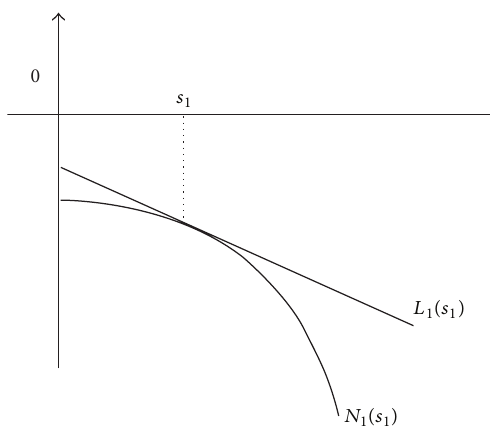
Figure 3: 𝑁 1 (𝑠 1 ) and 𝐿 1 (𝑠 1 ) for 0 ≤ 𝑠 1 ≪ 1 , ] ∈ 𝑆𝑁 2